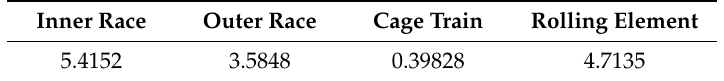
Figure 4. The rolling bearing experiment system and its sketch of Bearing Data Center of Case Western Reserve University. Table 1. Drive-end bearing defect frequencies (multiples of the running speed in Hz).